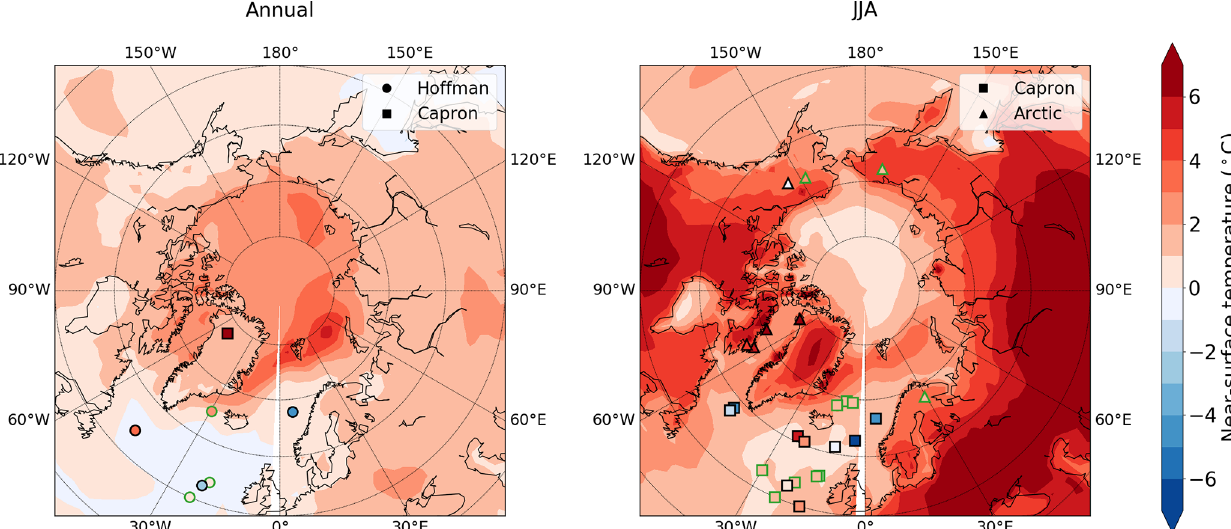
Figure 2. LIG–PI anomaly of the near-surface air temperature ( ◦ C) simulated by the IPSL-CM6A-LR model (colour shading) and recon- structed from proxy data synthesis (filled markers) as published by Otto-Bliesner et al. (2021). Symbols represent the source of surface air reconstruction: circles for the compilation by Hoffman et al. (2017), squares for the compilation by Capron et al. (2014, 2017) and triangles for the Arctic compilation. Sites showing good model–data agreement (i.e. considering a data uncertainty of ± 1 σ ) are indicated by a green